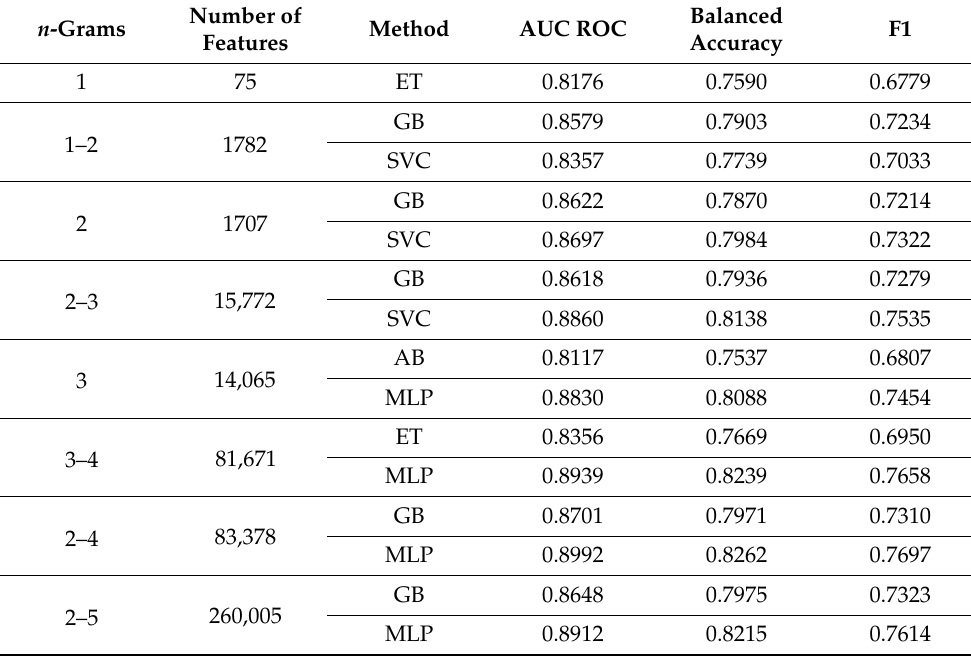
Table 8. The results of symbols classifications for the main data set. n -Grams